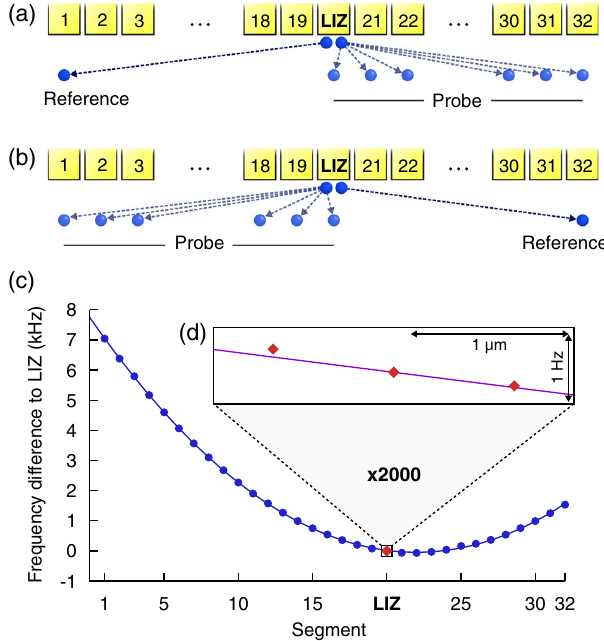
FIG. 5. Frequency differences from the LIZ. A sensor state is prepared, and the probe ion is moved to an arbitrary desired position. At the same time, the reference ion is either moved to (a) segment 1 or (b) segment 32 to maximize the ion distance. The results for each segment are shown in panel (c). In diagram (d), high-precision measurements close to the LIZ yield standard errors for the ion position and frequency difference of about 10 nm and 2 π × 10 mHz, respectively.